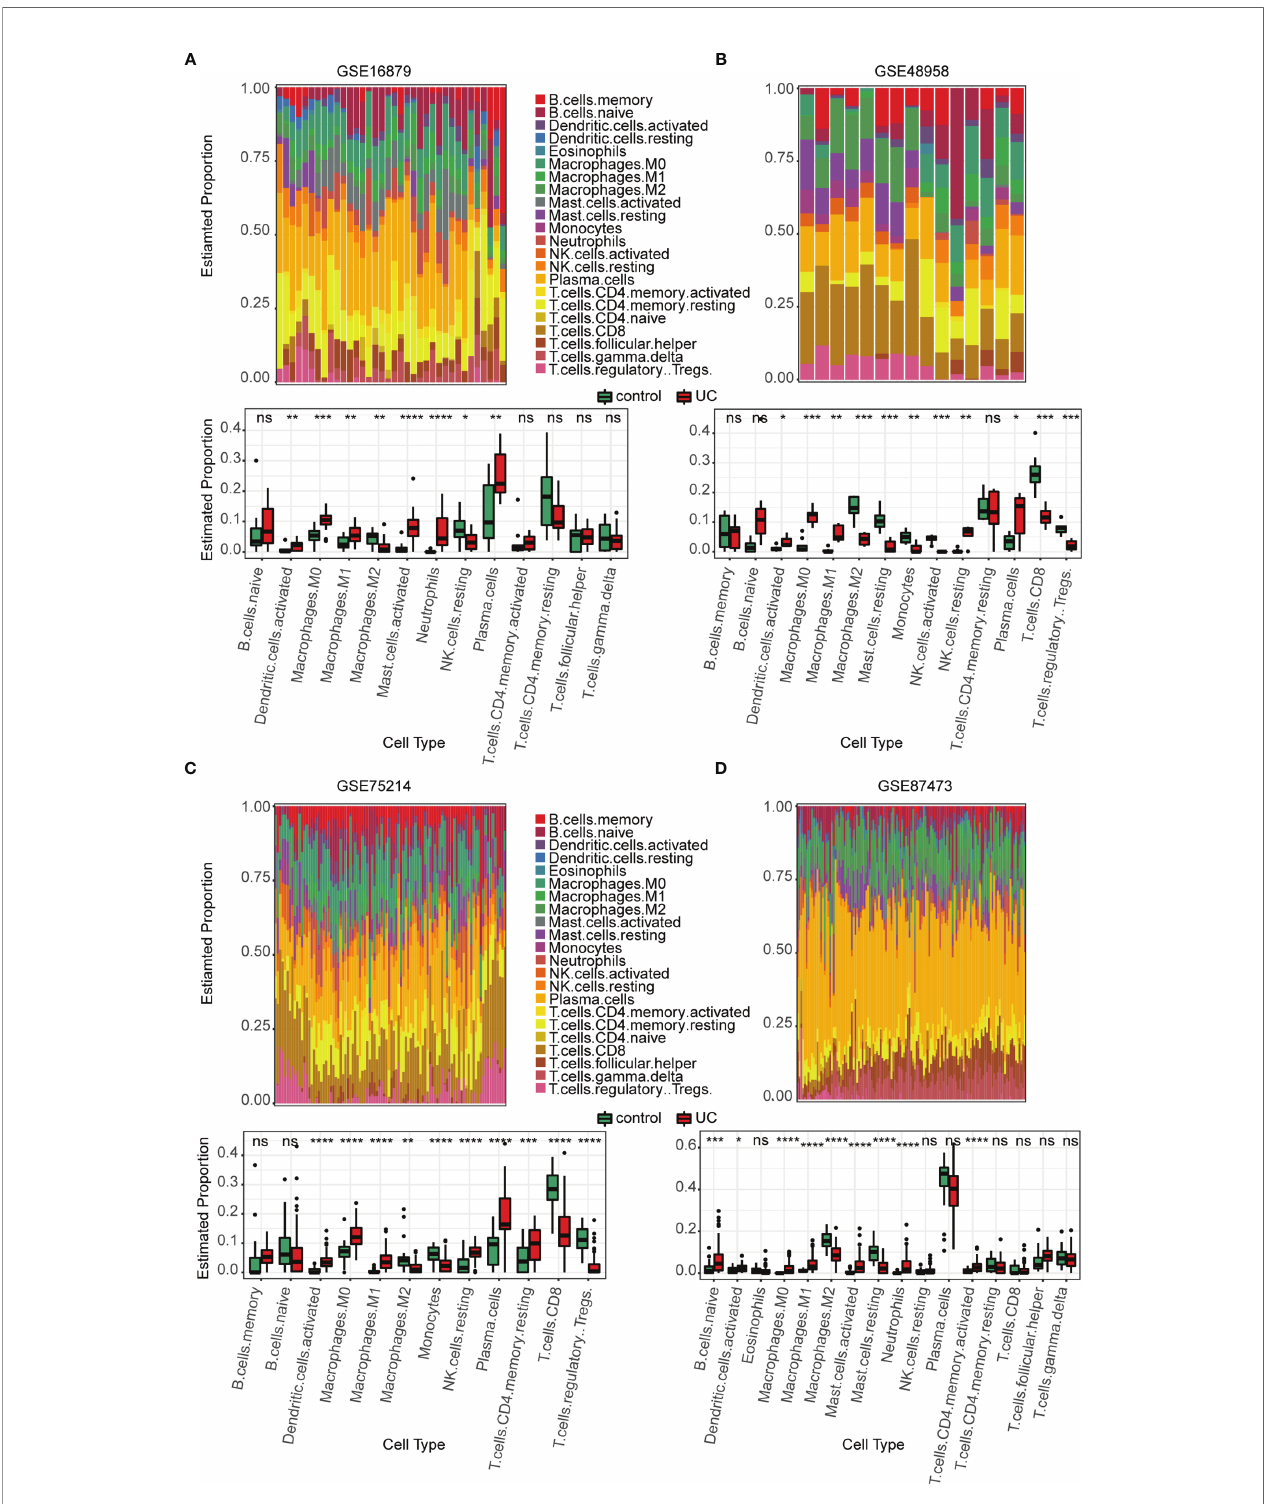
FIGURE 3 | Estimation of in fi ltrating immune cell types in the 4 training GEO cohorts via CIBERSORT. (A – D) Stacked barplots show the relative composition of 22 immune cell subsets in four cohorts, and the boxplots show that activated DCs and macrophages (M0 and M1) were signi fi cantly increased in the active UC group. Data were assessed via the method of Benjamini and Hochberg (BH). * adj. p- value < 0.05, ** adj. p- value < 0.01, *** adj. p- value < 0.001, **** adj. p- value <0.0001, ns, no signi fi